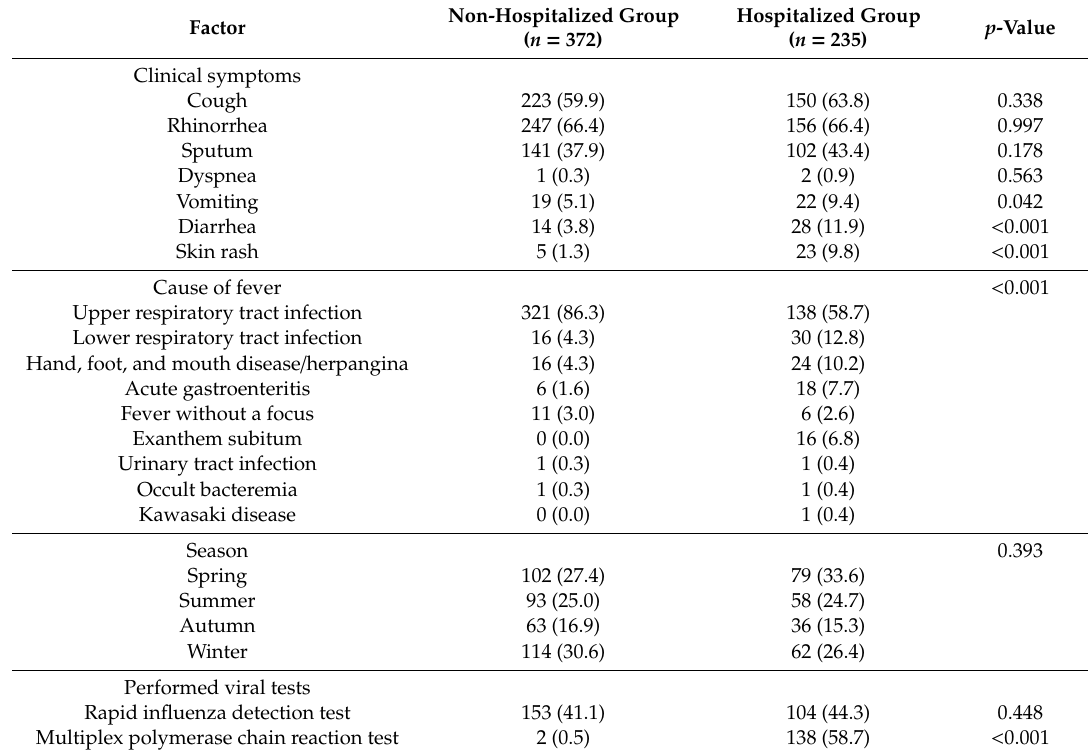
Table 2. Clinical symptoms and causes of fever in children presented with febrile